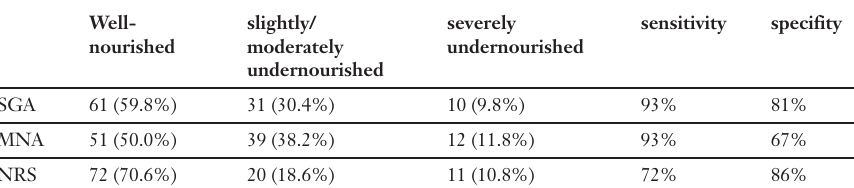
Table 6 Summary of compared nutritional